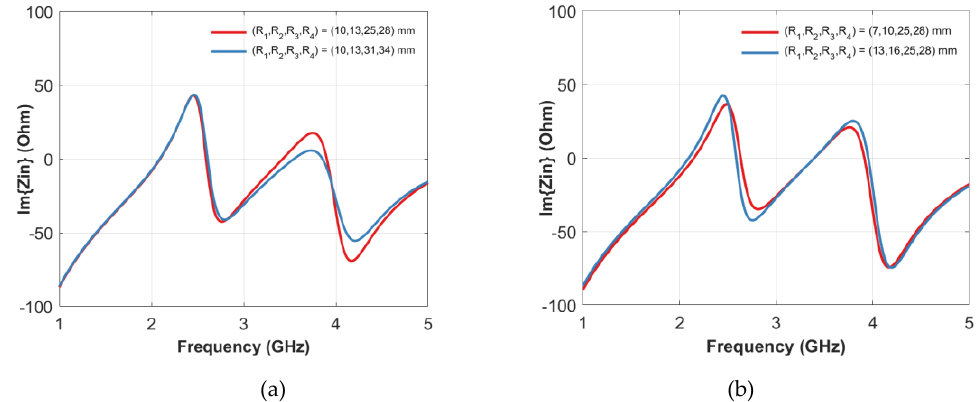
Figure 7. Imaginary part of the input impedance as a function of frequency in case the first empty ring is fixed and the position of the second one is changed ( a ), and by fixing the second empty ring and changing the position of the first one ( b ).